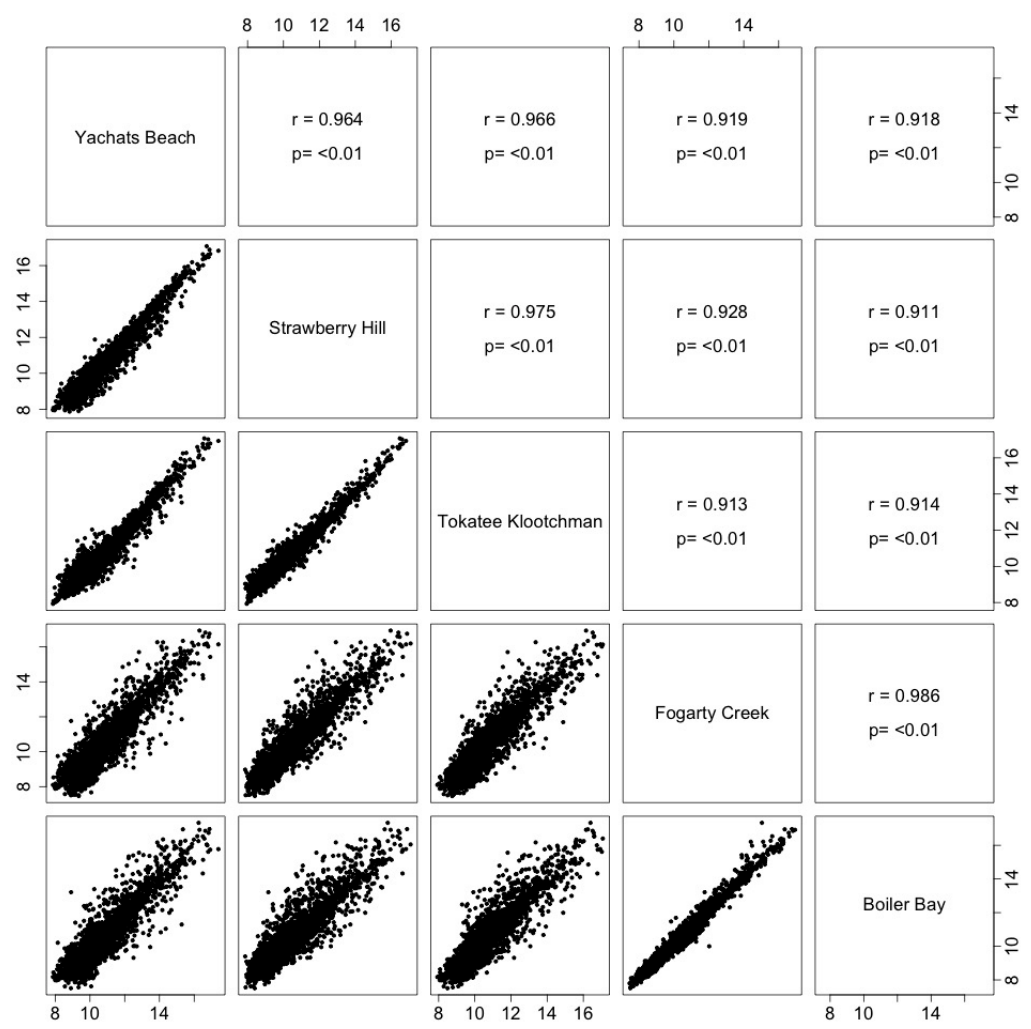
Figure 3. Correlation matrix of logger temperatures between each study site with the scatterplot shown in the bottom left and the Pearson r correlation coefficients shown in the top right of the figure. The study site names are shown in the middle diagonal boxes. The strongest correlation was between logger temperatures at Fogarty Creek and Boiler Bay, the two closest study sites. The weakest correlation was between logger temperatures at Boiler Bay and Strawberry Hill.